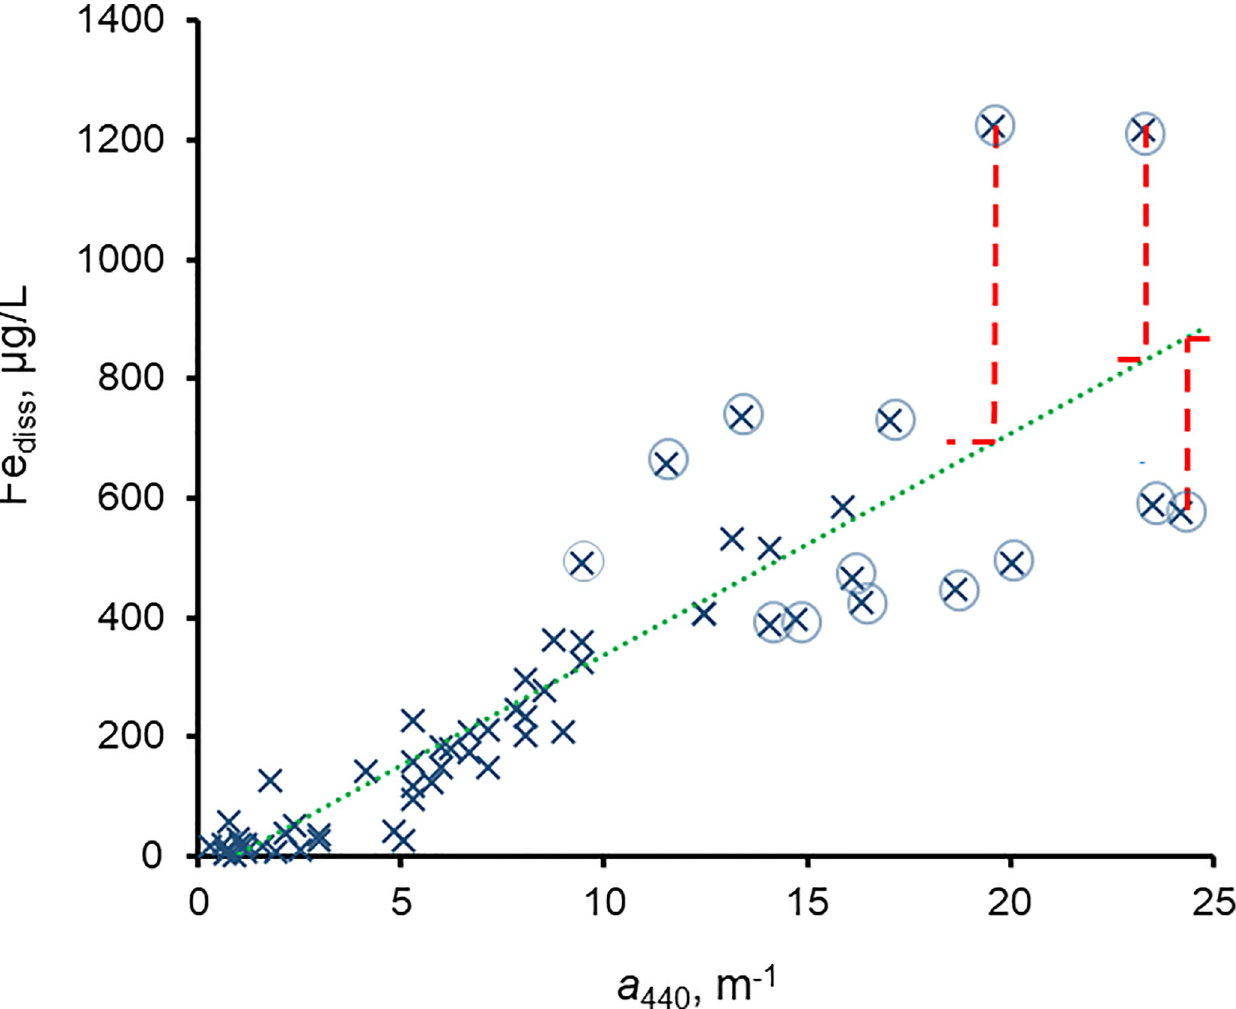
Fig 7. Fe diss vs. a 440 for 2015 data; best-fit regression line and statistics given in Table 2. Circled data: outliers examined for effects of Fe diss on a 440 (S6 Table). Dotted line: best-fit linear relationship: Fe diss = 36.8 a 440 − 30.7; R 2 = 0.79. Dashed lines illustrate change in a 440 for some outliers when Fe diss was changed to “best-fit”